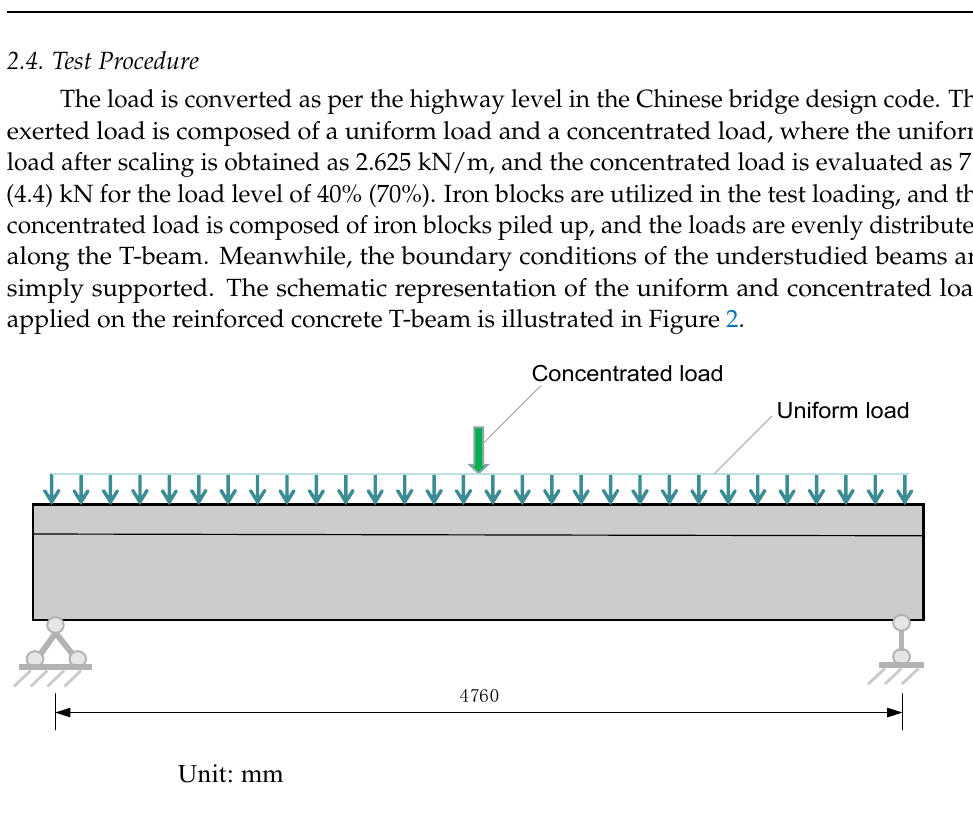
Figure 2. Loading diagram of the specimens.